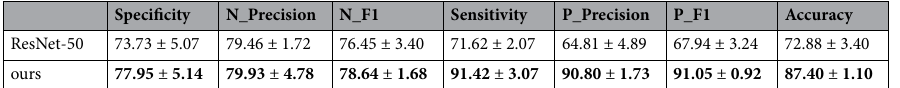
Table 7. Results on COVID-SC testing with four levels of severity: P_NORMAL, P_MILD, P_MODERATE and P_SEVERE. Bold values indicates the best results for each metric.